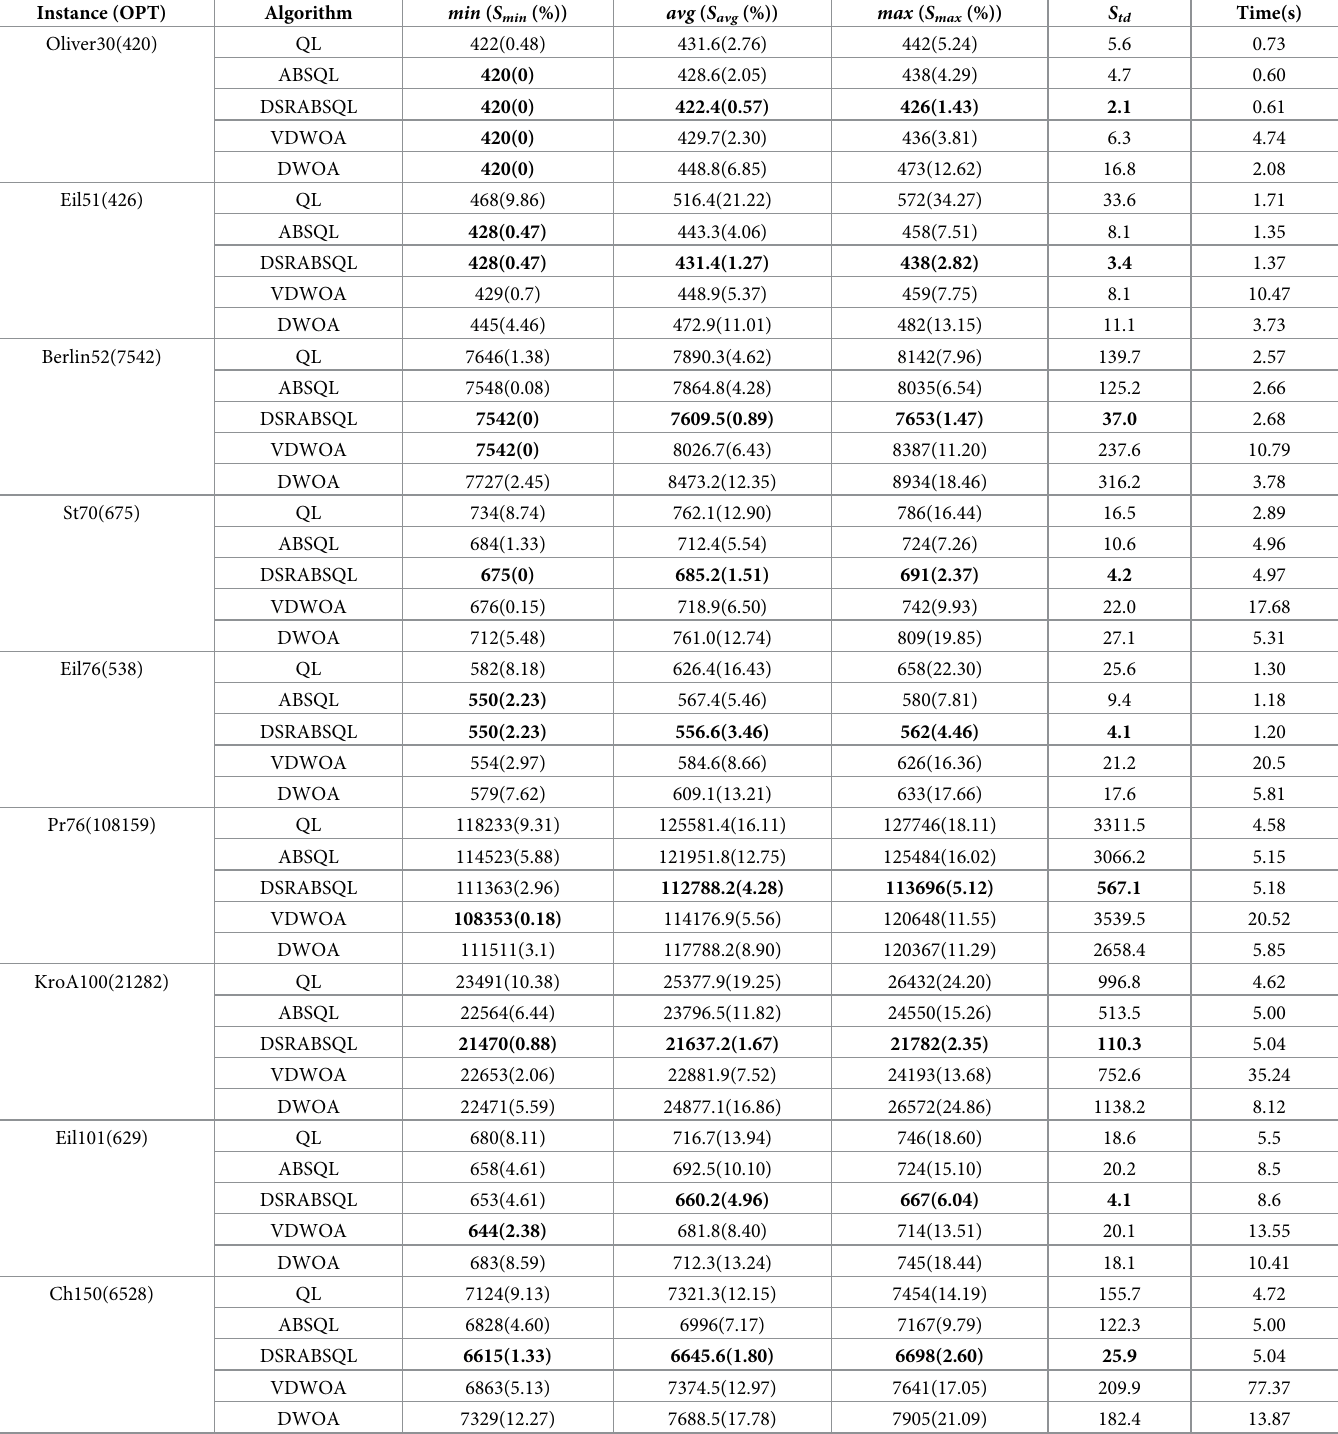
Table 2. Results of proposed algorithms and algorithms in [9] for 18